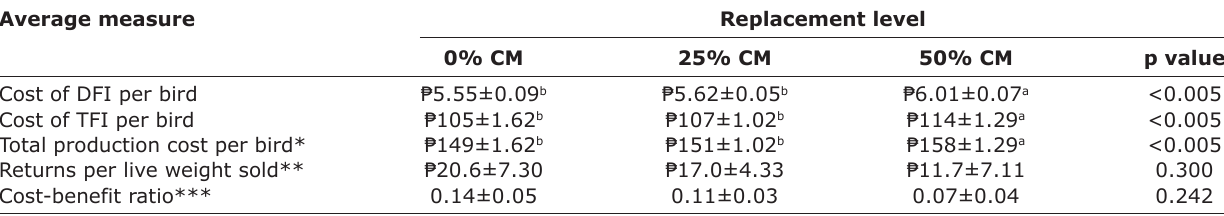
Table-5: Comparative production costs associated with the three dietary treatments in varying amounts of cocoyam meal as partial carbohydrate replacement for maize. Average